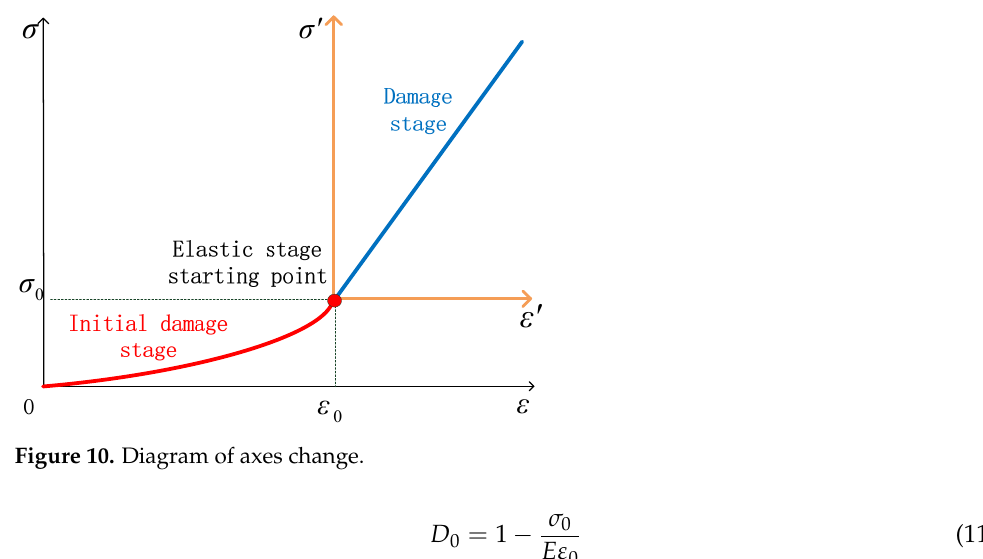
ε Figure 9. Damage variables vary with strain diagram. Yang et al. [55] introduced the seismological theory, proposed the AE multi ‐ parameters index, and carried out uniaxial compression tests on different sandstone samples (i.e., coarse sandstone, medium sandstone, fine sandstone, and siltstone) with a 0.03 mm/s strain rate. In his studies, the AE damage area experienced a decline, low ‐ value fluctuation, increase, and sustained high ‐ value stage. The AE damage area and damage